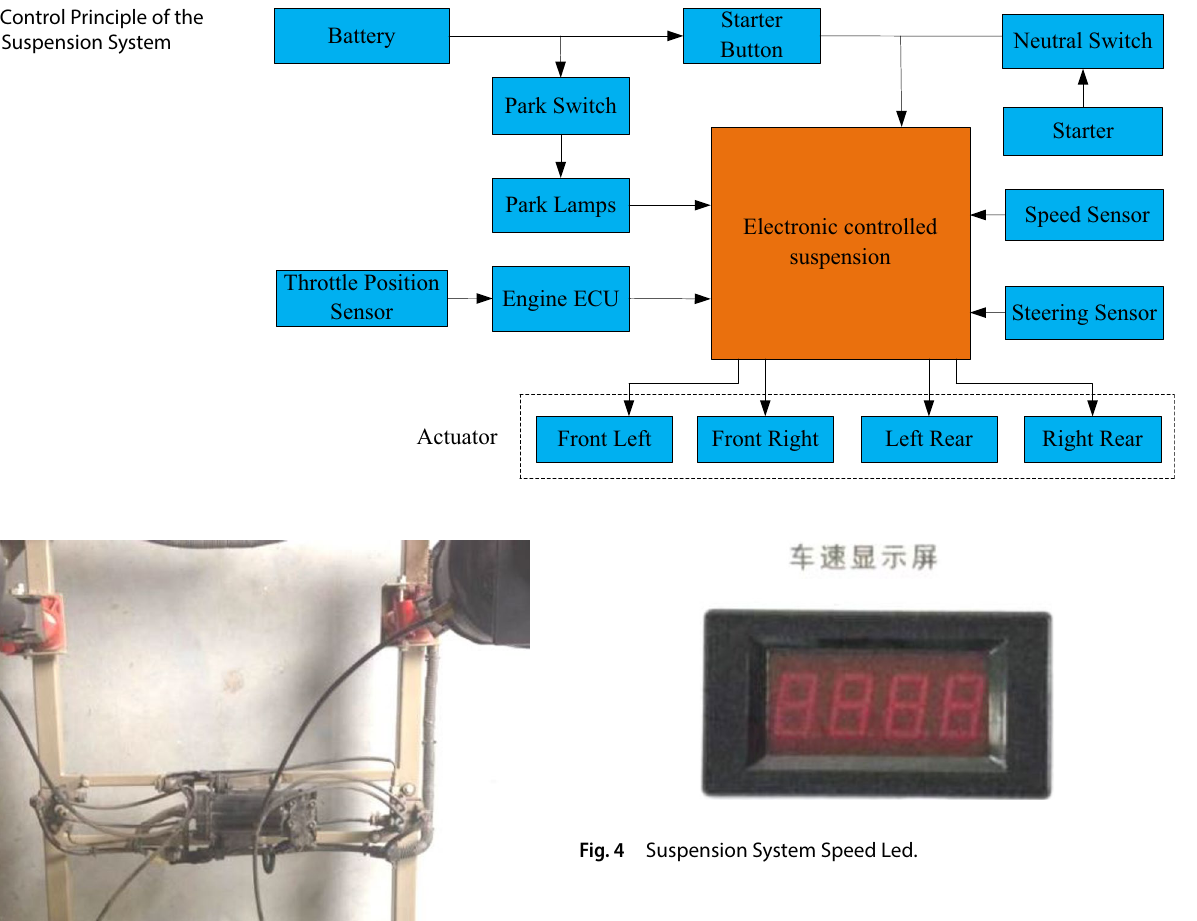
Fig. 2 Control Principle of the Active Suspension System